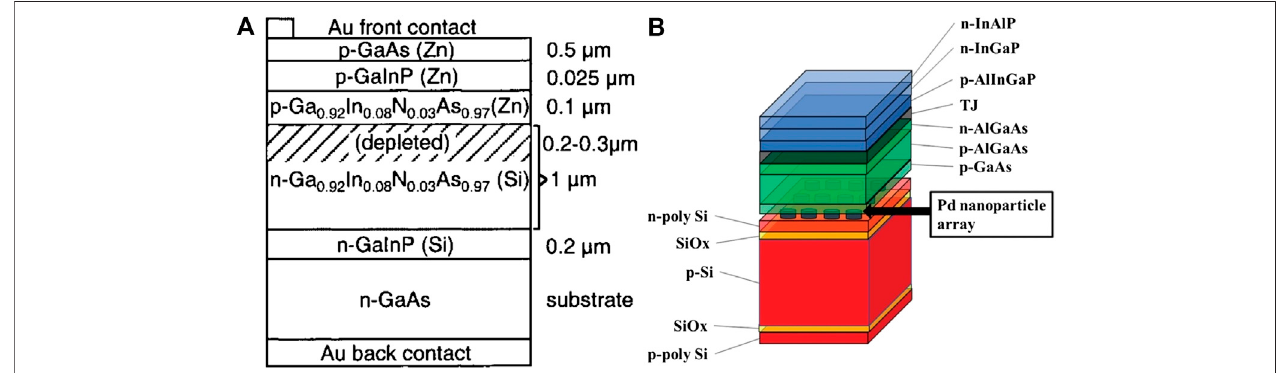
FIGURE1|(A) ThestructureofGaInNAsdevicegrownbyMOVPEwithdimethylhydrazineasthenitrogensource[50]; (B) ThestructureofInGaP/AlGaAs//Sitriple- junction solar cell [67].